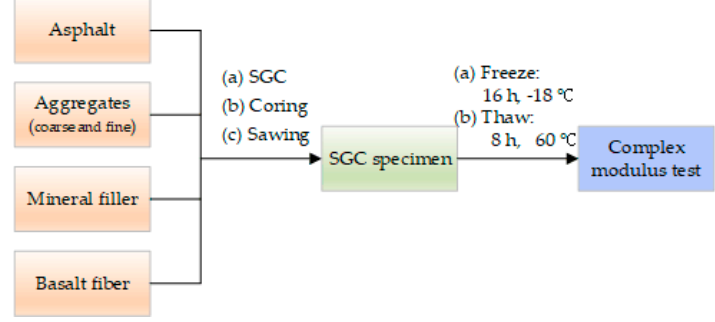
Figure 3. Experimental process flowchart.